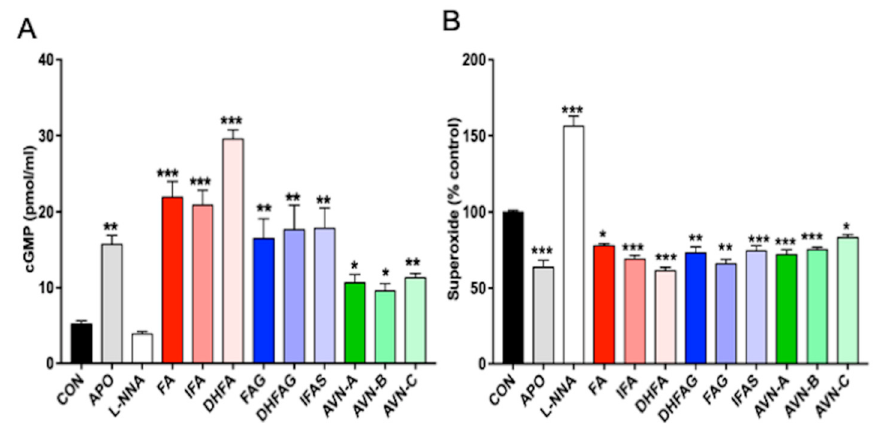
Figure 4. Cyclic GMP levels ( A ) and Superoxide levels ( B ) in HUVEC cells, measured after pre- treatment with the oat phenolics and metabolites (1 µ M), ferulic acid (FA) isoferulic acid (IFA), dihydroferulic acid (DHFA), FA glucuronide (FAG), DHFA glucuronide (DHFAG), IFA sulfate (IFAS), avenanthramide A (AVN-A) avenanthramide B (AVN-B) avenanthramide C (AVN-C), apocynin (APO, 100 µ M) or L-NG-Nitro-Arginine (L-NNA, 100 µ M) or controls (CON, vehicle) for 24 h. Data with error bars represent the average ± SEM of 3 independent experiments performed in duplicated for cGMP, and of 4 independent experiments performed in triplicate for Superoxide. * = p < 0.05, ** = p < 0.01, *** = p < 0.001 vs. control ( n = 6 for cGMP and n = 12 for superoxide).